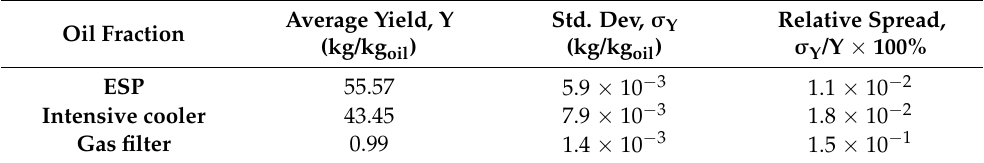
Table 8. Reproducibility of three identical experiments, with respect to the reactor conditions (Treactor = 500 °C, treactor = 0.6 – 1.1 s, thot = 0.6 – 1.1 s, fw, biomass = 10 – 12%). Average Yield, Y Oil Fraction